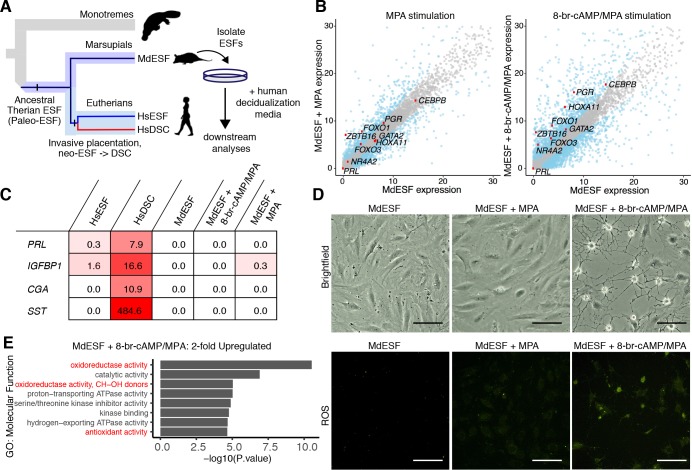
Transcriptomic and morphological response of MdESF to eutherian decidualizing stimuli.(A) Experimental strategy and cell type phylogeny of mammalian ESF cell types. ESFs in crown group marsupials and placentals are homologous and descend from a common ancestral therian ESF. In eutherians, DSCs arose from ancestral eutherian ESFs and thus is a sister cell type to eutherian ESFs. (B) Transcriptional response of core regulatory genes involved in eutherian decidualization in MdESF treated for 2 days with either MPA or decidualizing stimuli. Blue dots represent significant differential expression relative to unstimulated MdESF (n = 3, p < 10−6). Grey dots represent no significant change in expression. Each point represents the mean of three replicates. (C) Gene expression heatmap (mean of three replicates in TPM) of classical decidual markers in HsESF, HsDSC, and MdESF treated with decidualizing stimuli for 2 days. Mean of three replicates is shown. (D) Morphological response of and ROS detection in unstimulated MdESF and MdESF stimulated with either MPA or decidualizing stimuli for 3 days. ROS detection by treatment with H2DCFDA, a general oxidative stress indicator. Scale bars are 10 μm. (E) Differential expression of up-regulated GO categories in MdESF treated with decidualizing stimuli for 2 days relative to unstimulated control (n = 3, adjusted P values for each GO term are shown). Terms related to oxidative stress are indicated in red. Underlying data are provided in S1 Data (Fig 1E) and S2 Data (Fig 1B). Human transcriptome data were previously published in Kin and colleagues [8]. Unedited silhouettes of a monotreme and a marsupial are credited to Sarah Werning and are used under license http://creativecommons.org/licenses/by/3.0/. DSC, decidual stromal cell; ESF, endometrial stromal fibroblast; GO, gene ontology; H2DCFDA, 2′,7′ dichlorodihydrofluorescein diacetate; HsDSC, human decidual stromal cell; HsESF, human endometrial stromal fibroblast; MPA, medroxyprogesterone acetate; ROS, reactive oxygen species; TPM, transcripts per million